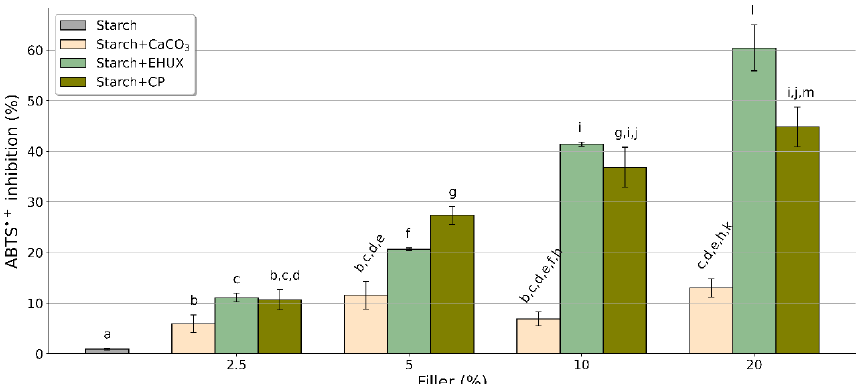
Figure 5. Water vapor permeability (WVP) of pristine starch films (control) and starch-based films containing commercial CaCO 3 , E. huxleyi (EHUX), or C. pseudoroscoffensis (CP) at different percentages (2.5, 5, 10, and 20% w / w ). Different letters between each condition indicate significant differences (Student’s t -test; p < 0.05).